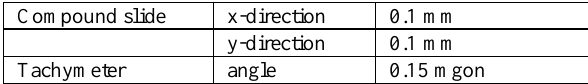
Figure 10. Experimental setups for verifying the accuracy of a rotation (left) and position